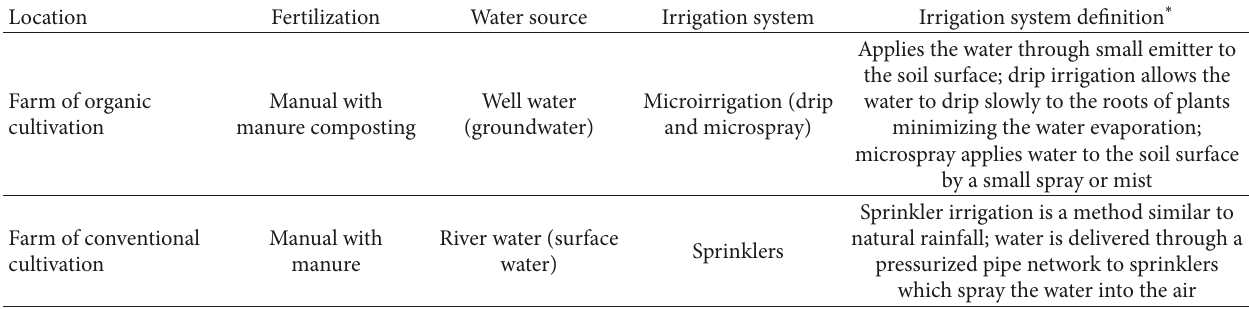
Table 1: Summary of the characteristics of the two evaluated